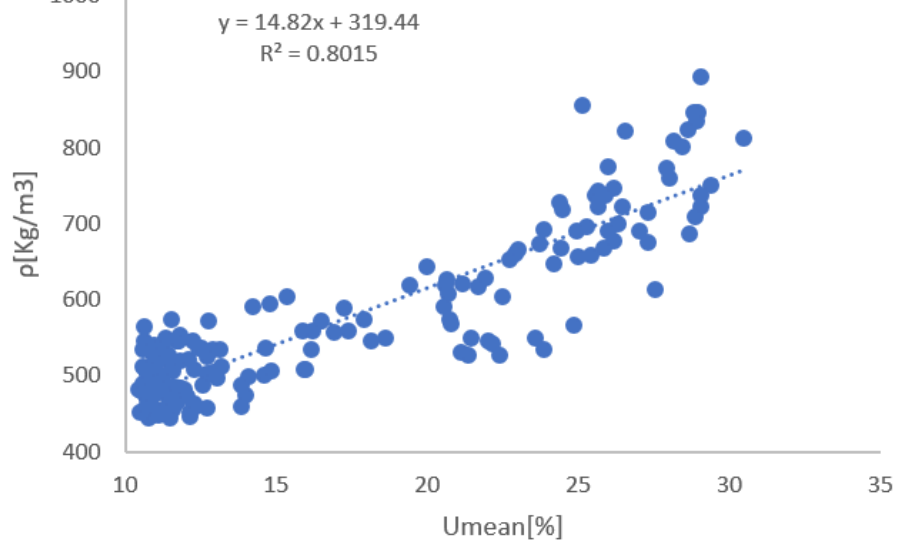
Figure 4. Density ρ as a function of moisture content U.